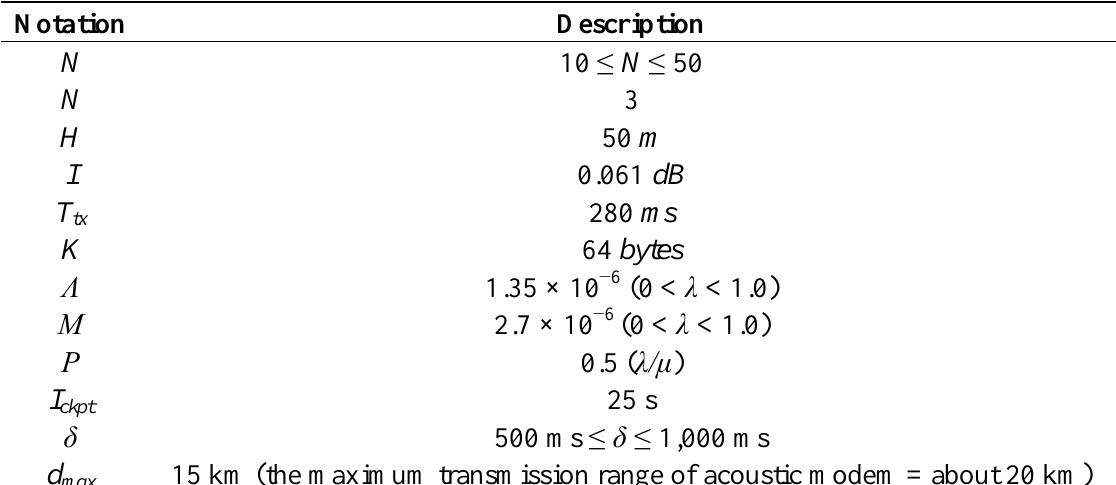
Table 2. Parameters for the